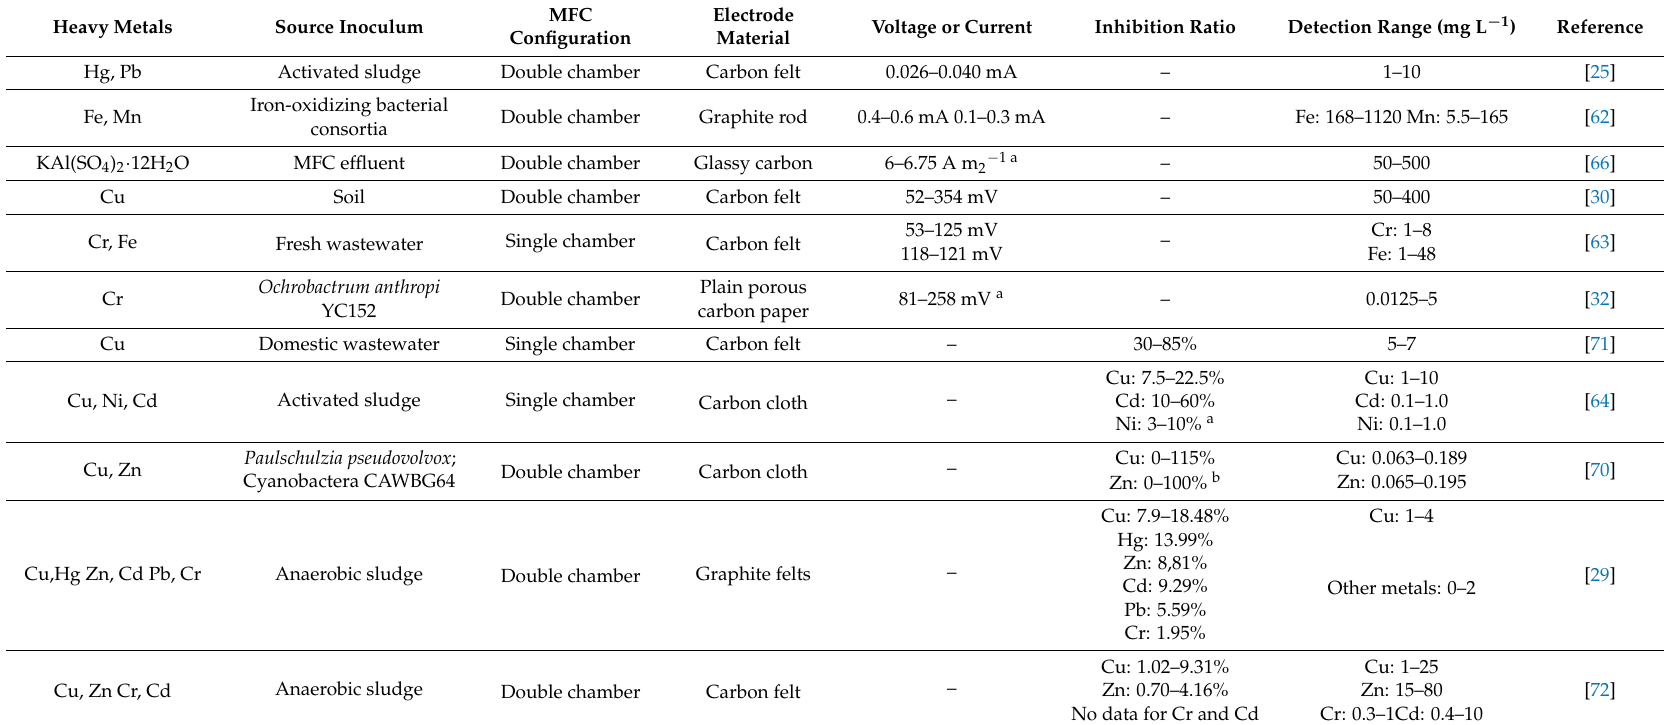
Table 2. MFCs as heavy metal